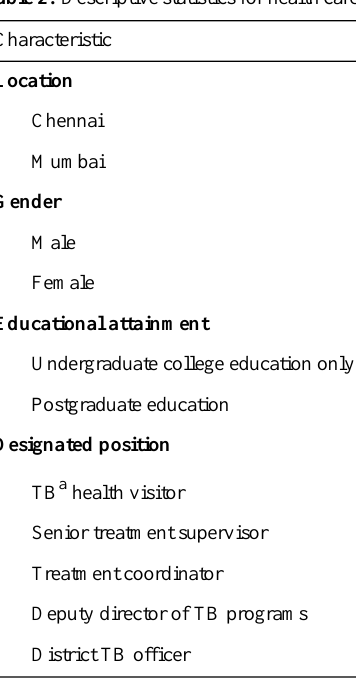
Table 2. Descriptive statistics for health care providers who were interviewed to understand their acceptance of the Medication Event Reminder